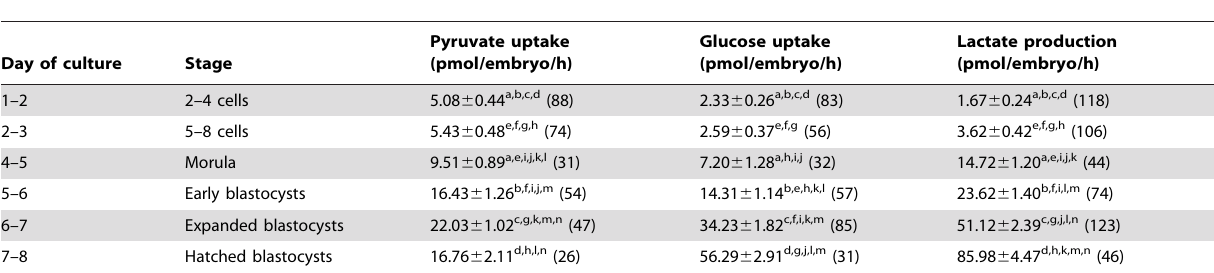
Table 1. The uptake of pyruvate and glucose and the production of lactate by individual bovine embryos produced in vitro .